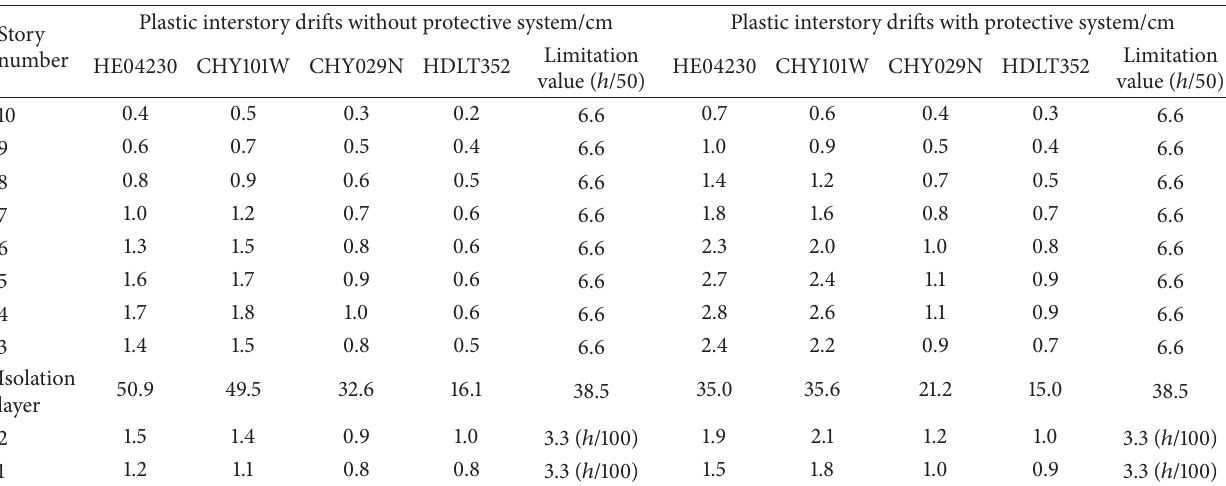
Table 4: Comparison of plastic interstory drifts of midstory isolations with and without protective system.